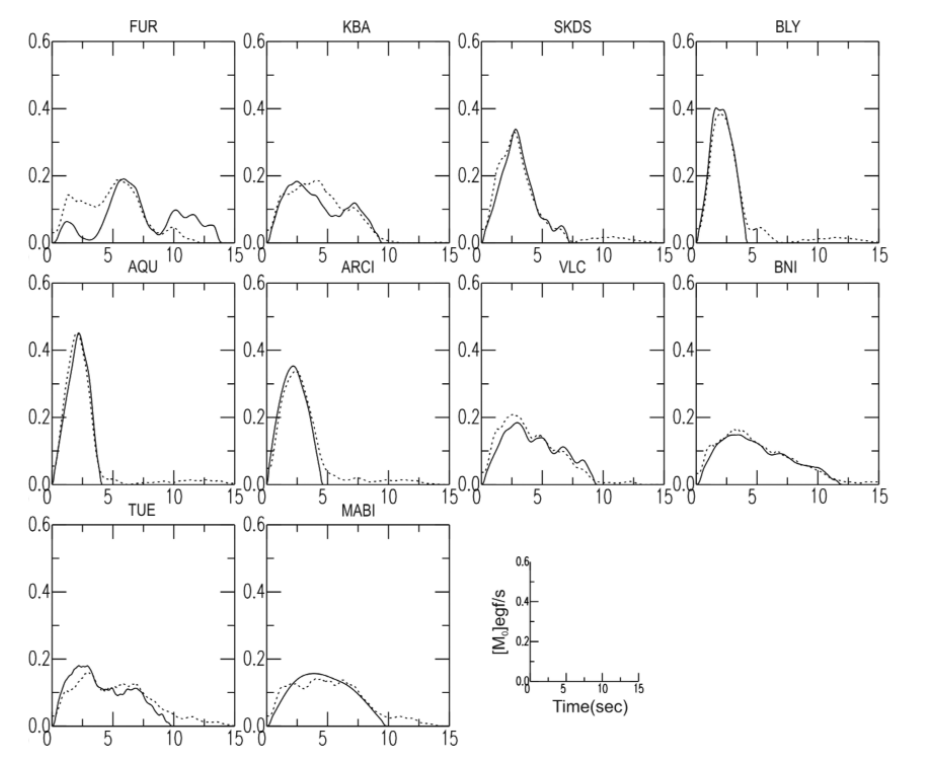
Figure 3. Comparison of synthetic (dashed lines) and computed STFs at the ten stations shown in Figure 1. Synthetic STFs were derived using the slip distribution model of Figure